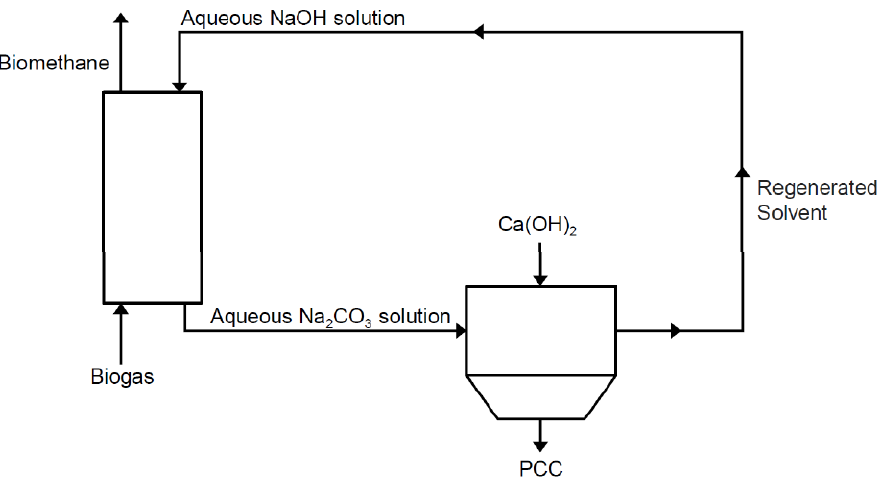
Figure 1. Biogas upgrading through Precipitated Calcium Carbonate (PCC) production.